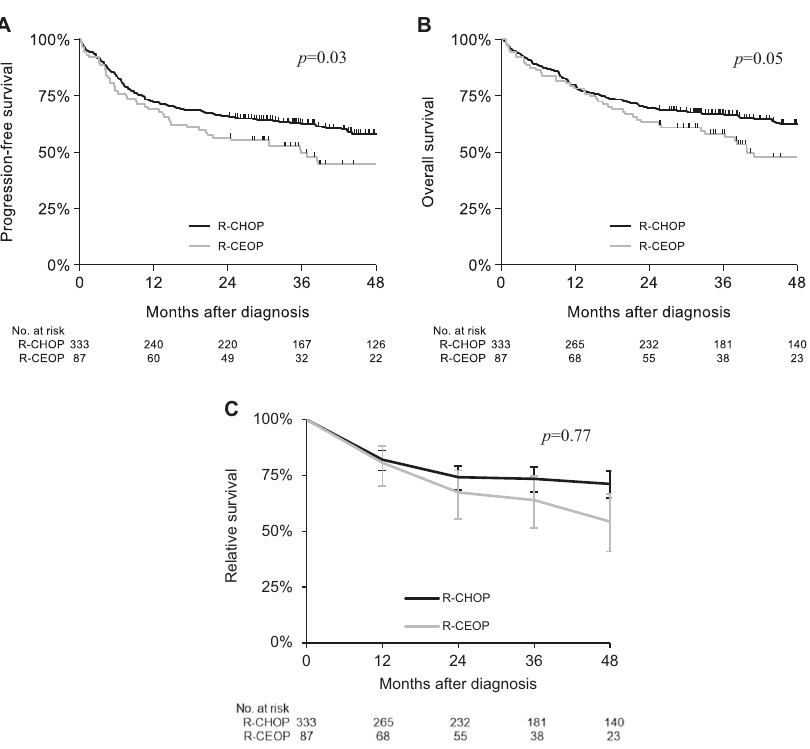
Fig. 2 Survival analysis. A Progression-free survival (PFS) of patients with diffuse large B-cell lymphoma (DLBCL) treated with R-CEOP and R-CHOP. Kaplan – Meier curves showing signi fi cant inferior 4-year PFS in patients with DLBCL treated with R-CEOP ( p = 0.03). B Overall survival (OS) of patients with diffuse large B-cell lymphoma (DLBCL) treated with R-CEOP and R-CHOP. Kaplan – Meier curves showing a signi fi cant inferior 4-year OS in patients with DLBCL treated with R-CEOP ( p = 0.05). C Relative survival (RS) of patients with diffuse large B-cell lymphoma (DLBCL) treated with R-CEOP and R-CHOP. Kaplan – Meier curves showing no signi fi cant difference in 4-year RS in patients with DLBCL treated with R-CEOP ( p = 0.77).